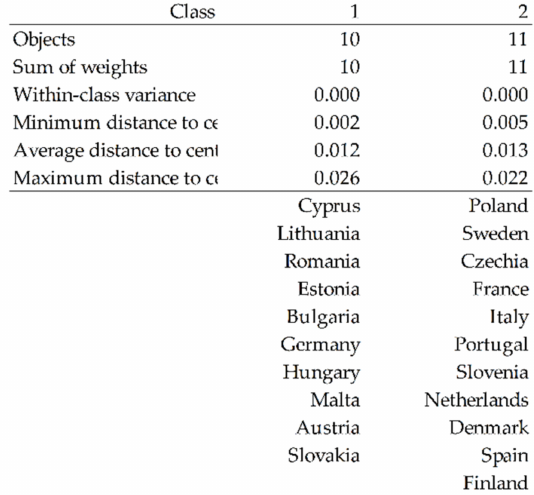
Figure 9. Countries clustered by the share of enterprises using industrial robots (k = 2). Source: Au- thor’s Contribution. Data retrieved from Eurostat. Robotics and 3D Printing Data, https://ec.europa. eu/eurostat/databrowser/bookmark/f29db2df-2e19-4bfd-8bb4-af630dc3e907?lang=en, accessed on 9 January 2022.